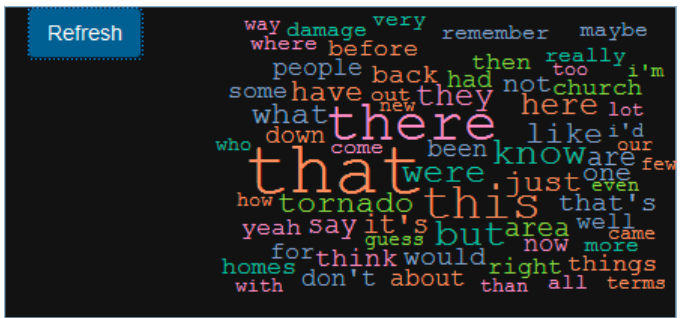
Figure 9. A combined wordcloud for ‘Location specific’ and ‘Fuzzy Space’.